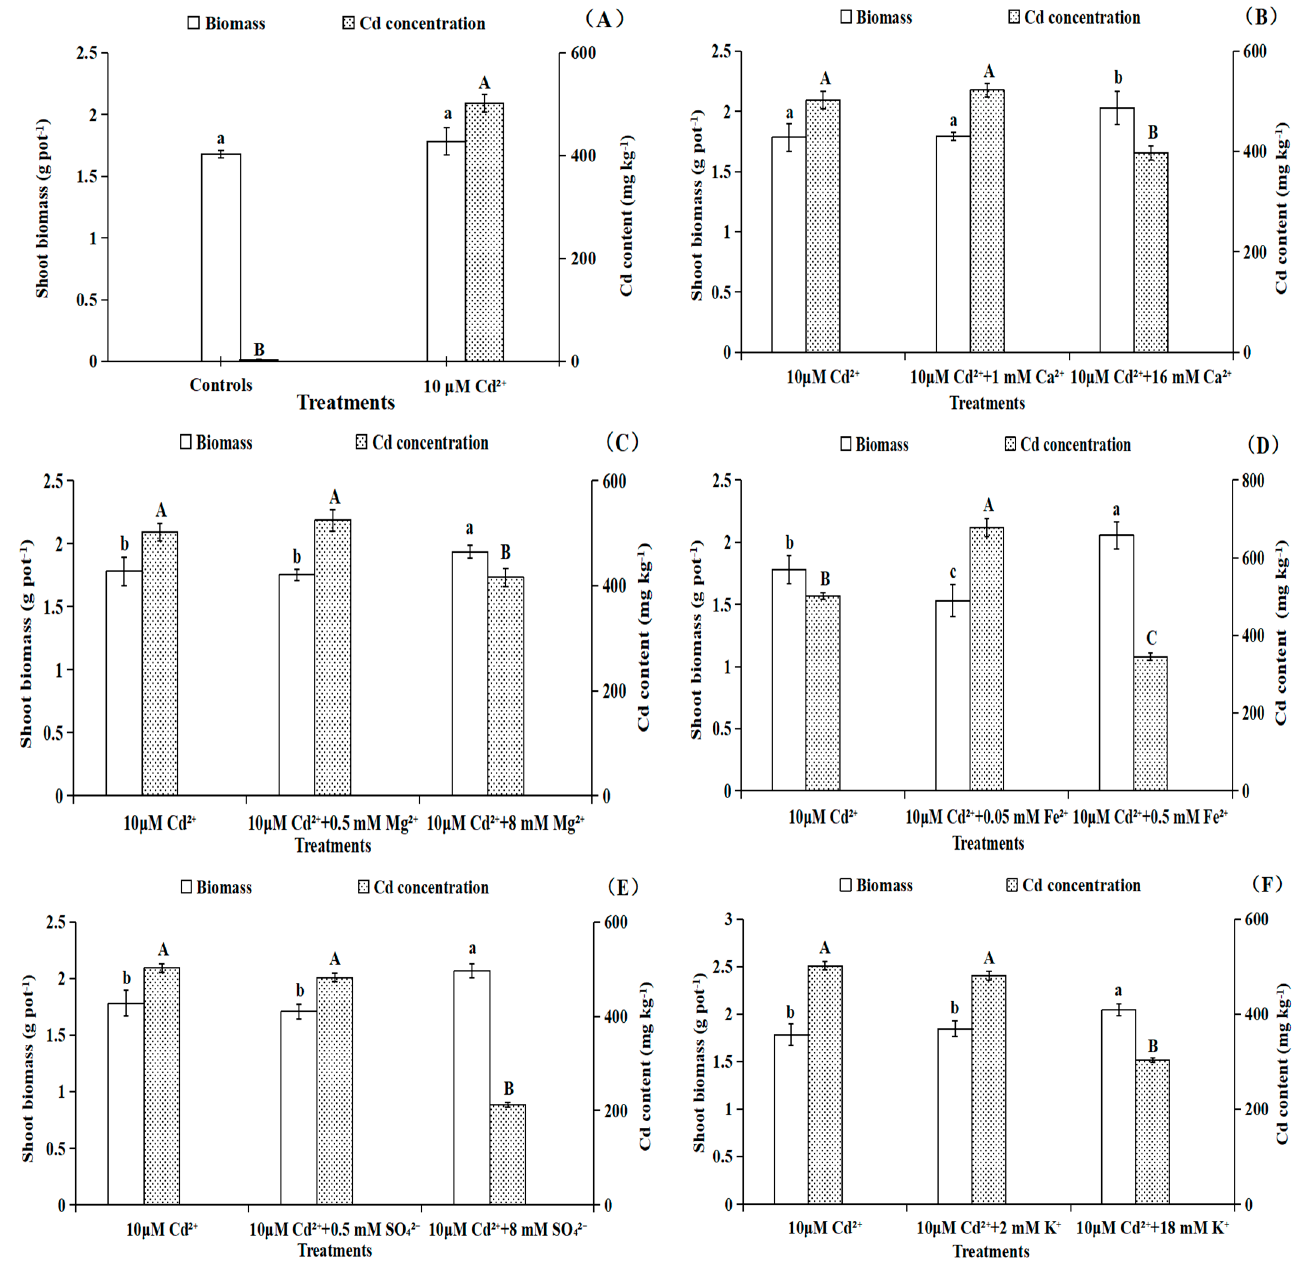
Figure 2. The shoot biomass and Cd contents of Bidens pilosa L. from control groups ( A ) and Cd treatment groups with different concentrations of Ca 2+ ( B ), Mg 2+ ( C ), Fe 2+ ( D ), SO 42 − ( E ) and K + ( F ). Notes: the Cd contents were from the whole seedling of B. pilosa , the means of biomass under different treatments marked with the same lowercase letters (a–c) were not significantly ( p > 0.05) different, and the means of Cd contents under different treatments marked with the same uppercase letters (A–C) were not significantly ( p > 0.05) different.